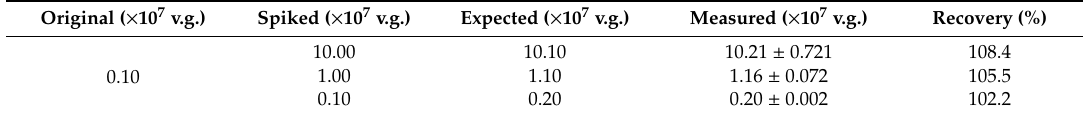
Table 3. Analytical Recovery determined by adding purified AAV2 to crud lysate.